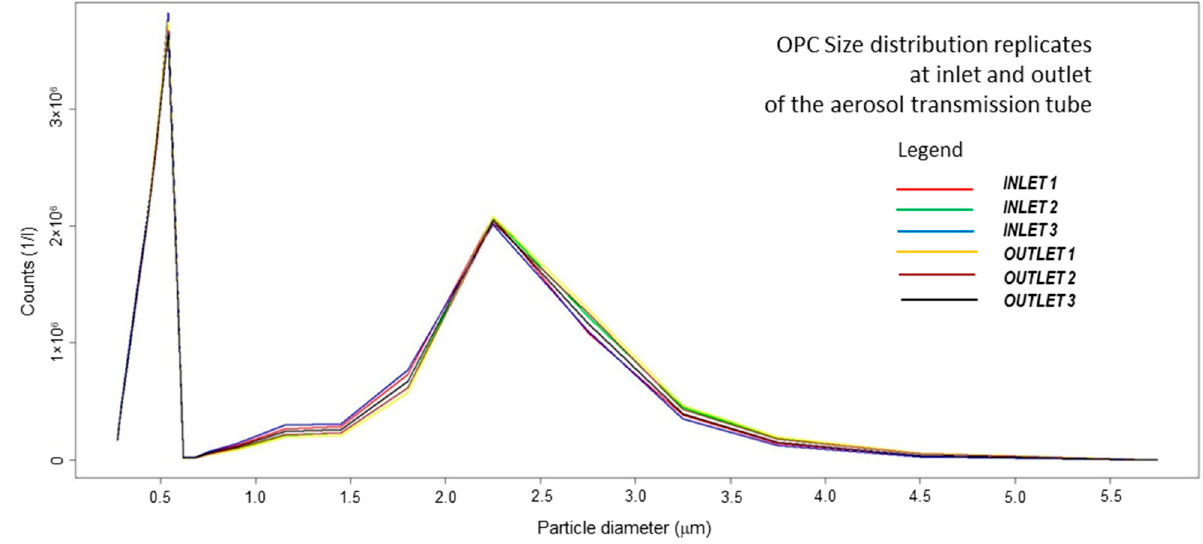
Figure 2. Size distribution replicates determined by Optical Particle Counter, reporting average number concentrations (particle counts/liter) for each of the 20 dimensional bin spanning the range from 0.25 to 5.0 µm (particle diameter of the center of the bin, in micrometers). Three replicate cycles (16 size spectral acquisition each) are measured at the inlet (3 runs) and three cycles were acquired at the outlet of the aerosol transmission tube.